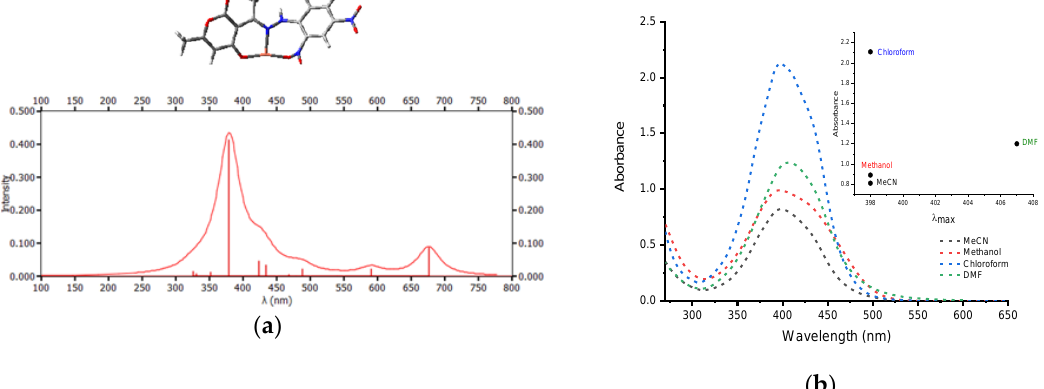
Figure 1. Optimized (by the UB3LYP / 6-31G* method) ( a ) copper complex geometries and their UV–Vis spectra; ( b ) UV–Visible spectra of HLCuCl complex in MeCN, methanol, and chloroform, and in a DMF concentration of 10 − 4 M.